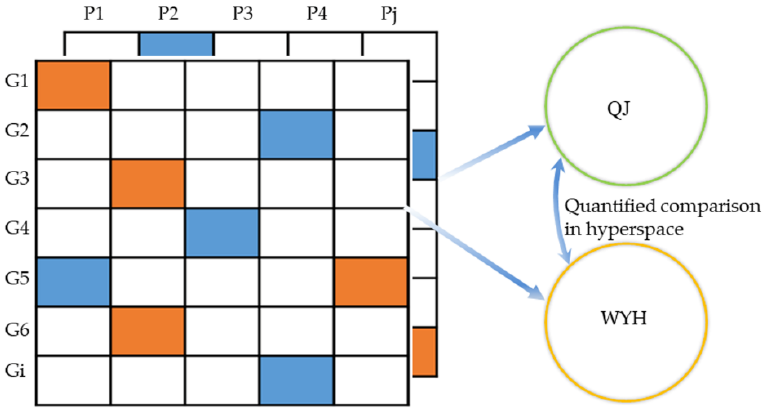
Figure 6. Schematic of the quantitative pathway profile. For the rows Gi corresponds to gene i . For the columns, Pj refers to pathway j . The red color means that foldchange >2; the blue color means foldchange <0.5; the white color means genes which are not in pathways.